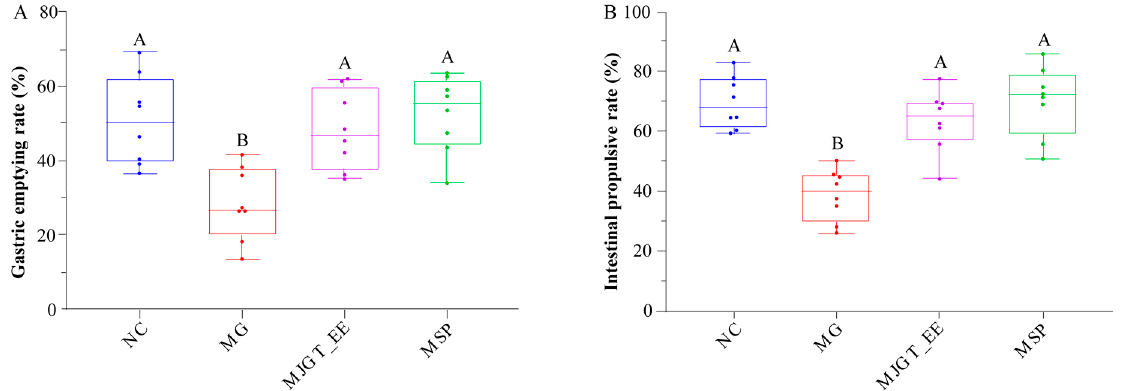
Figure 2. Effect of MJGT_EE on gastric emptying rate ( A ) and intestinal propulsive rate ( B ) in vivo. Capital letters above the bar indicate the difference significance at the 0.01 level. ( n = 8 for each group). NC: negative control group; MG: model group, MSP: mosapride group, MJGT_EE: Mao Jian Green Tea ethanol extract group.